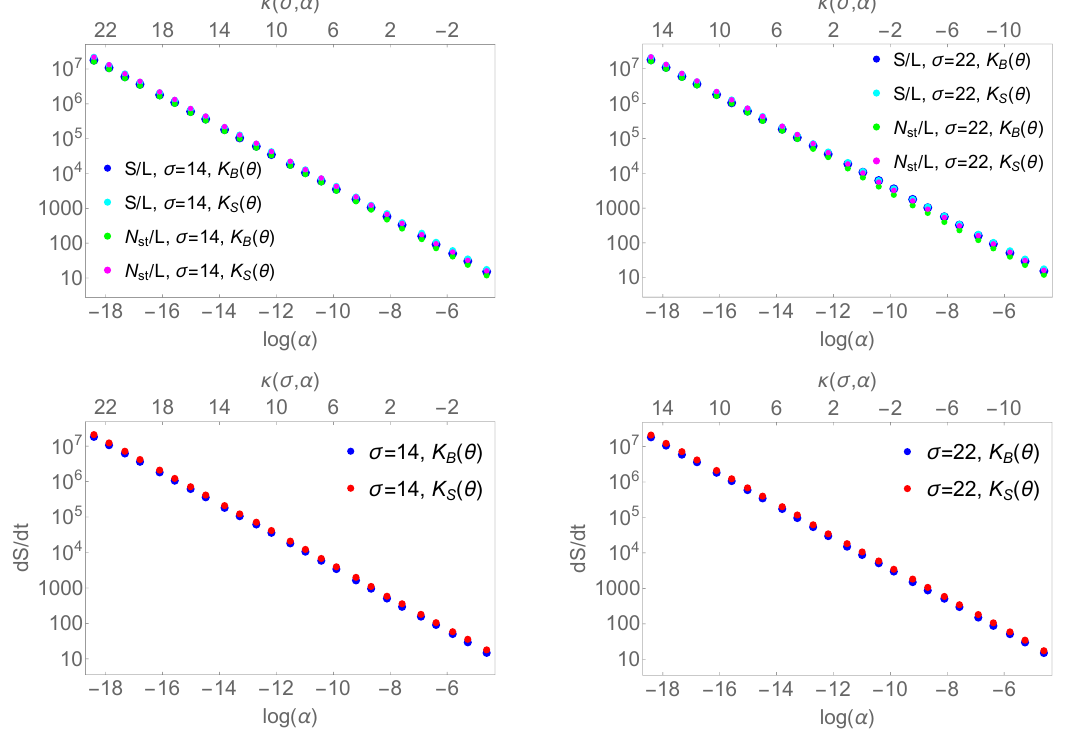
Figure 2 . S { L , N st { L and d S { d t as functions of log α after quenches with different K -functions and fixed resonance parameter σ (reported in the legend). Note the log scale on the vertical axis. The bottom and top of the labels are respectively the values of log α and of κ the indices t S , B u because κ p σ, α q » ´ 2 log α ´ σ for α ! 1